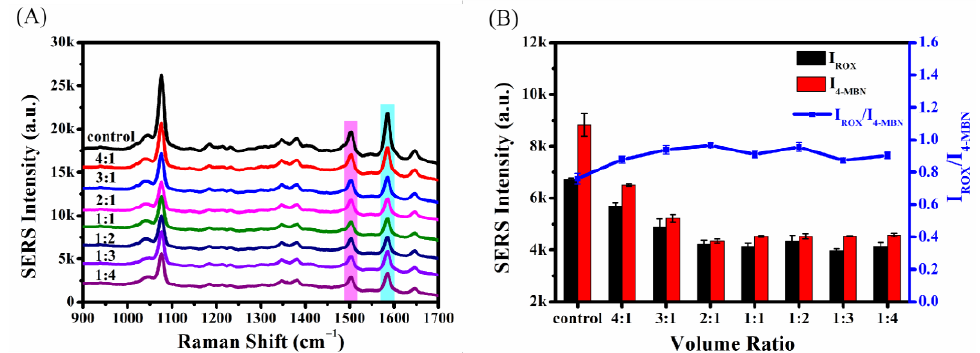
Figure 5. Results of optimizing the volume ratio of SERS probe to enrofloxacin. ( A ) SERS spectra of samples prepared with different volume ratios of the SERS probe to enrofloxacin (control: SERS probe). ( B ) Comparison of intensities of the characteristic SERS signals of ROX and 4-MBN at Raman shifts of 1503 cm −1 and 1586 cm −1 and their corresponding ratios.